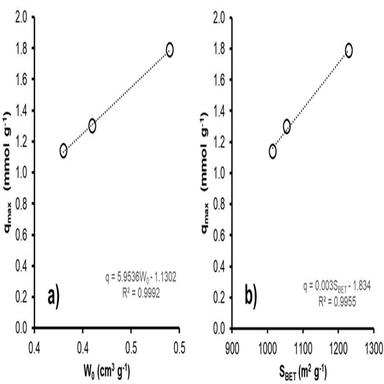
Relationship between the adsorption capacity of atenolol versus a) Pore volume and b) BET surface area of the materials studied.